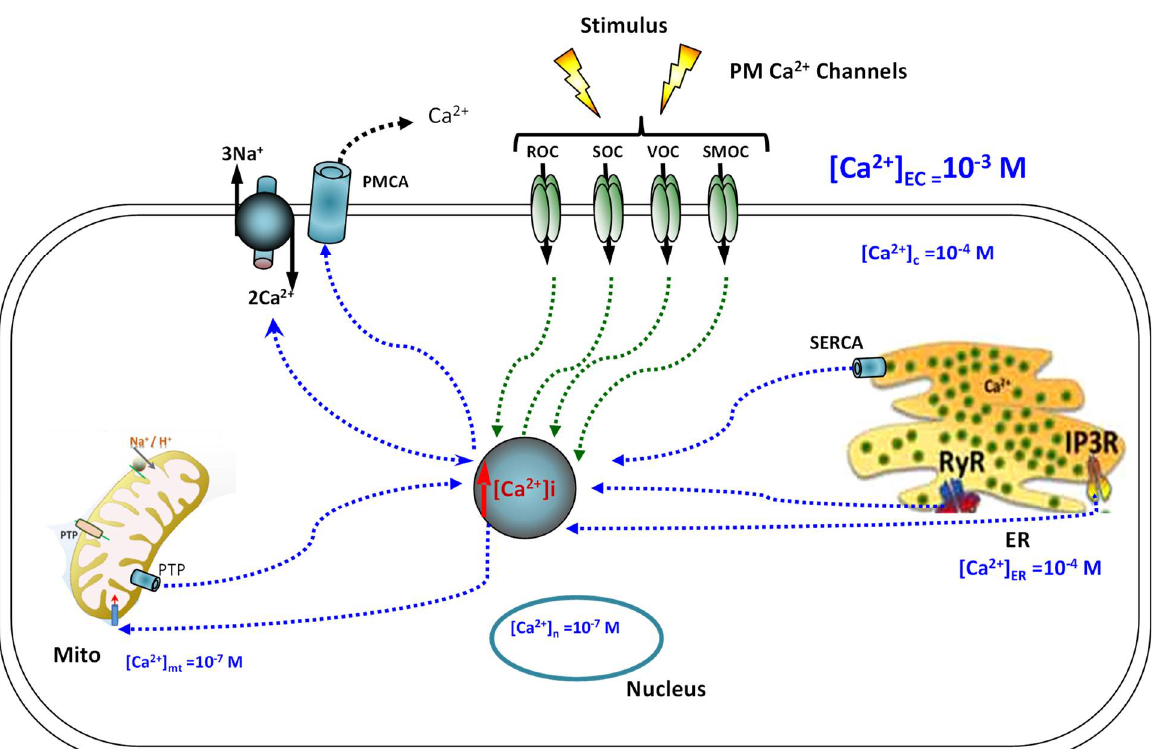
Figure 2. General concept of Ca 2+ -signalling homeostasis. Stimuli induce both the entry of external Ca 2+ and the release Ca 2+ from the internal stores of the ER/SR via IP3R and RYR. In activated cells, Ca 2+ enters cells through different types of Ca 2+ channels, including voltage-operated channels (VOC), second messenger-operated channels (SMOC), store-operated channels (SOC), and receptor-operated channels (ROC). We note that VOCs are activated by membrane depolarization and SMOCs are activated by small messenger molecules, such as InsP3. In resting cells, Ca 2+ is removed from the cell by exchangers and pumps. The NCX and PMCA extrude Ca 2+ from the cytosol to the extracellular milieu, whereas the ER/SR Ca 2+ -ATPase (SERCA) pumps pump Ca 2+ back into the ER. Mitochondria also have an active function during the recovery process in that they sequester Ca 2+ rapidly through a uniporter, which is then released more slowly back into the cytosol.